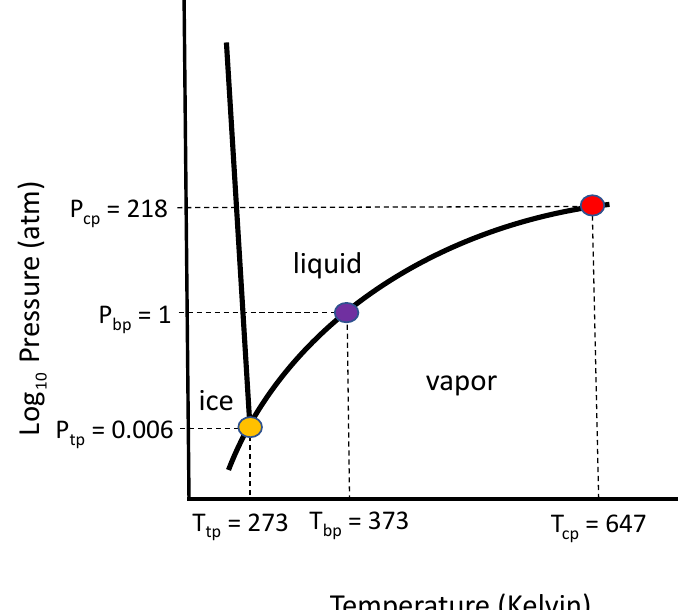
Figure 4. Pressure versus temperature phase diagram of water for a fixed number of molecules, n, at a fixed volume (constant specific volume V = V / n ). Each point in the phase diagram corresponds to an equilibrium state, while the lines separating the phases (solid–gas, solid–liquid, liquid–gas) depict sublimation, melting, and vaporization, respectively. The three lines for water intersect at the triple point (0.006 atm, 273.16 K), and the vaporization curve ends at the critical point (218 atm, 647.14 K). The melting point of pure water (1 atm, 273.15 K) is adjacent to the triple point, while the boiling point (1 atm, 373.15 K) is located near 3/5 of the critical point temperature (647.14 K). Beyond the critical point, the liquid and gas phases are